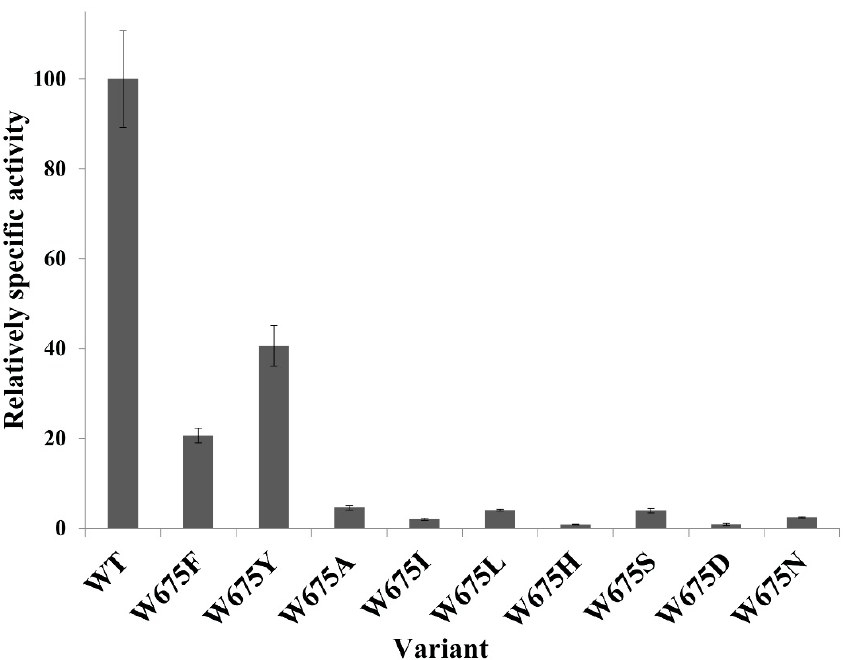
Figure 2. Comparison of relatively specific activity. All substituted mutants at W675 and WT alternansucrase were compared with specific activity. Activity assayed by DNS method. Protein content measured by Bradford assay.